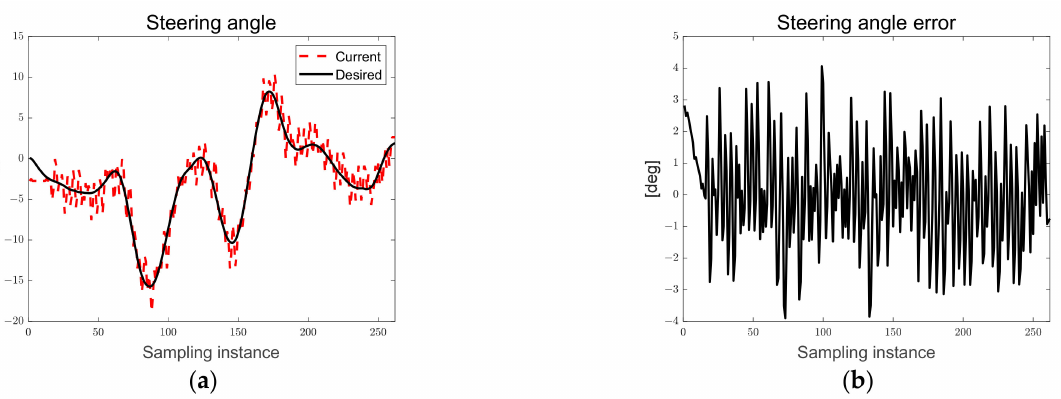
Figure 23. Lane-change path tracking scenario results; ( a ) desired and current steering angles; ( b ) steering angle